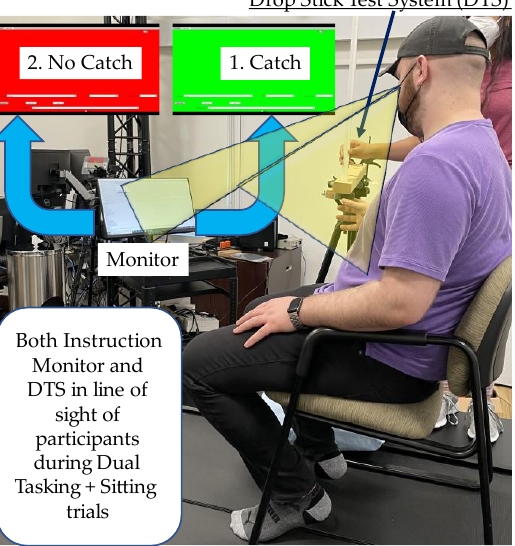
Figure 3. This picture shows the experimental setup for the dual-task condition. The participant sat and waited for instructions from the monitor, which randomly and instantaneously turned ‘green’ or ‘red’ after the drop. The participant was to ‘catch’ the stick if the monitor screen turned ‘green’ or let the stick fall (‘no catch’) if the screen turned ‘red.’.